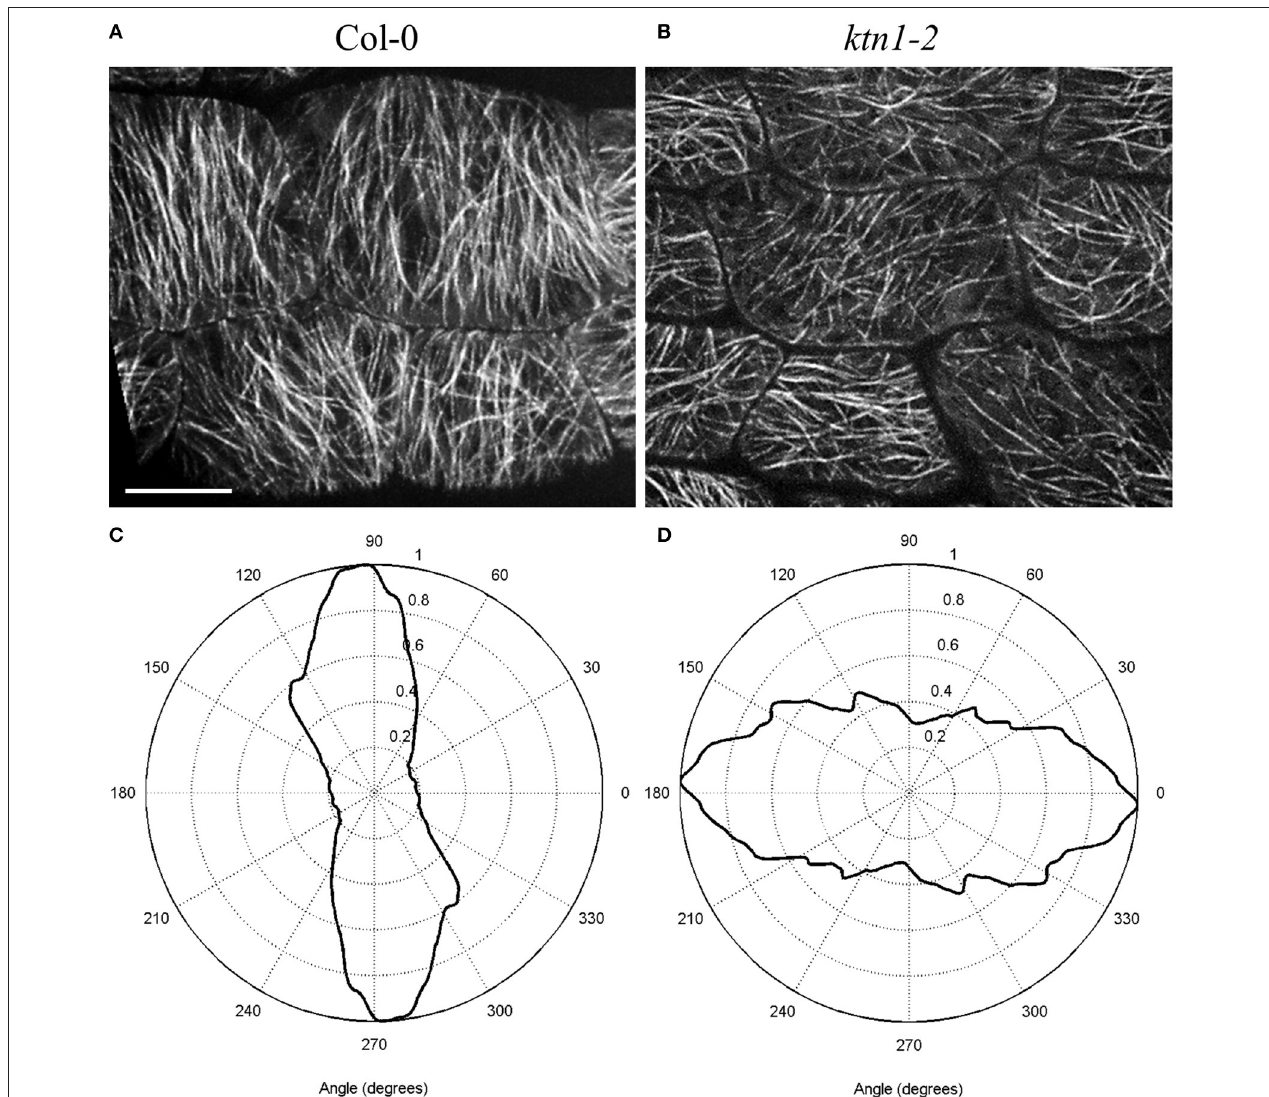
FIGURE 2 | Differences in the microtubule organization and cell shape of Arabidopsis thaliana Col-0 and ktn1-2 petiole epidermal cells carrying a GFP-TUA6 microtubule marker after spinning disk microscopy imaging. In differentiated cells, most cortical microtubules are transversal to the cell axis in Col-0 showing parallel placement to each other (A) resulting in relatively narrow angular distribution (C) whereas they appear more disorganized and randomly oriented in ktn1-2 (B) exhibiting broader angular distribution pattern (D) . Scale bar = 10 µ